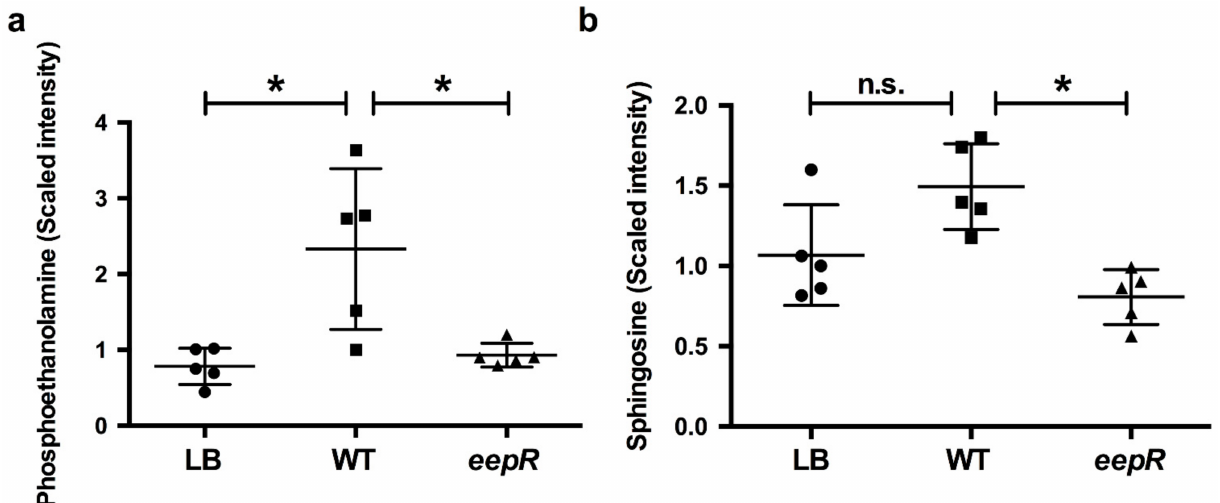
Figure 2. Metabolomic analysis demonstrates alteration of sphingosine and lipid metabolism in corneal cells challenged by S. marcescens secretomes. HCLE cells were treated with LB, WT, or eepR secretomes for 24 h. Mean and SD (n = 5) of relative amounts of ( a ) phosphoethanolamine and ( b ) sphingosine. Circles = LB (mock treatment), squares = WT, and triangles = eepR mutant treated HCLE cells. Asterisks (*) indicate p < 0.05 by one-way ANOVA with Tukey’s post-hoc analysis. n.s., not